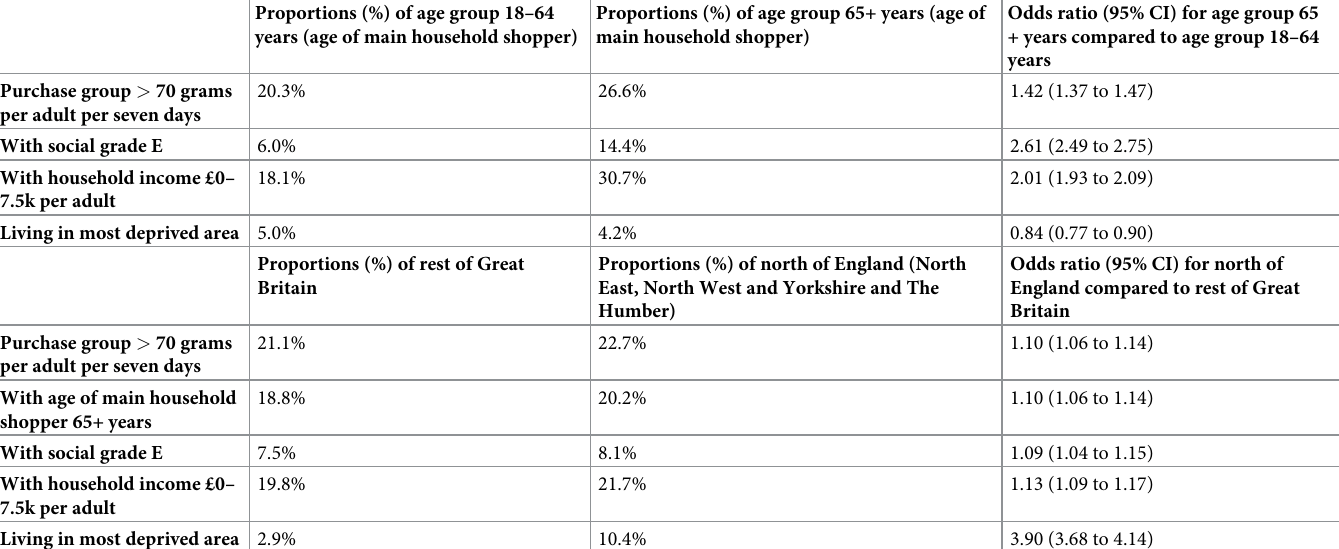
Table 3. Differences in socio-demographic factors by age of main shopper and geographic location of household.